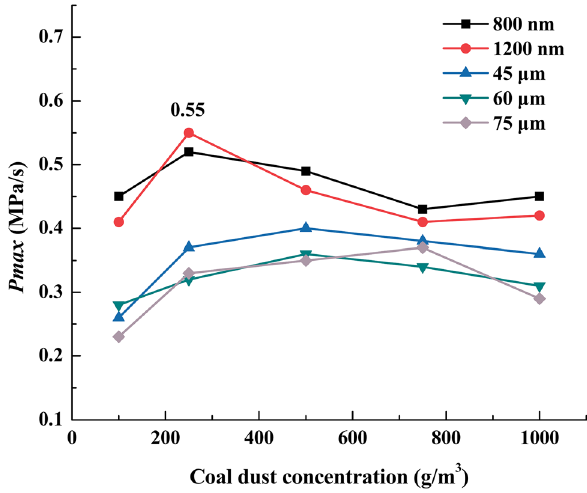
Fig. 8 The maximum coal dust